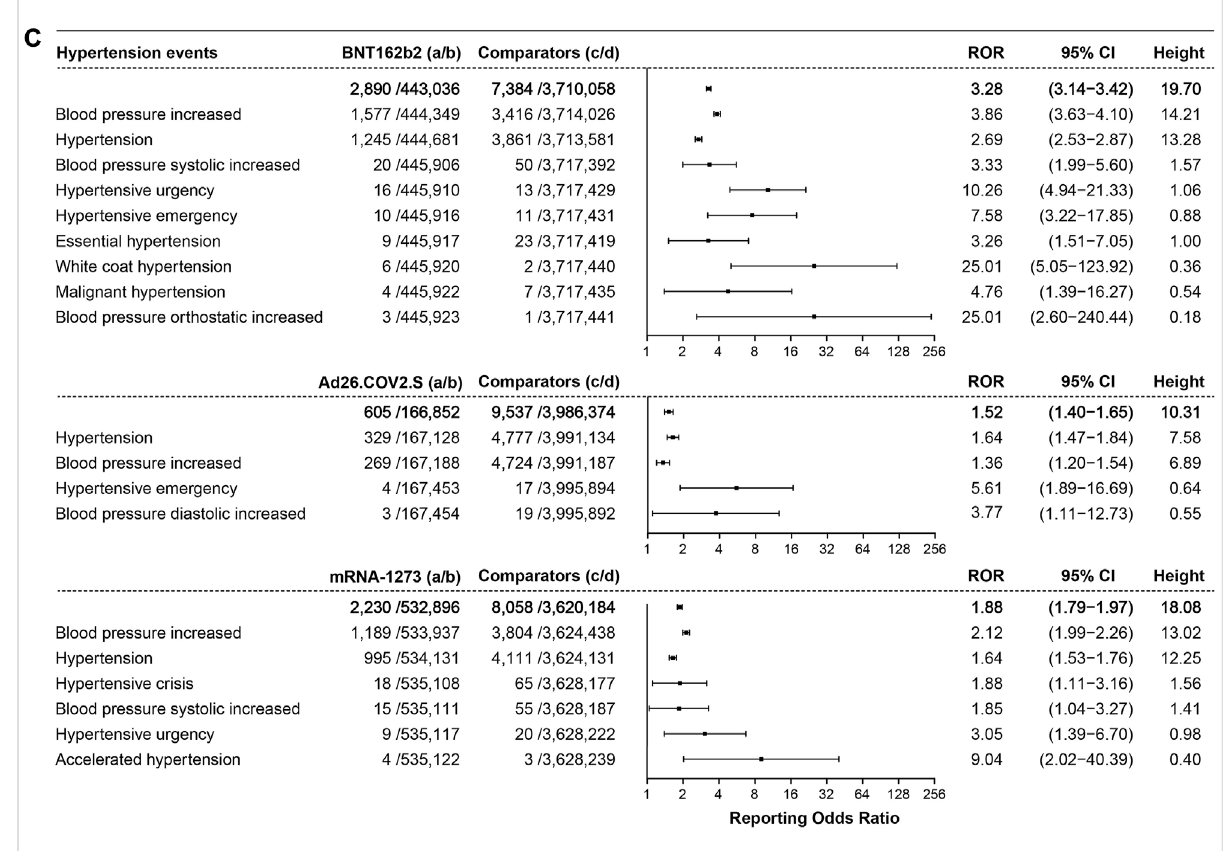
FIGURE 6 (C) ROR values and height of theCOVID-19 vaccinesof BNT162b2-, Ad26.COV2.S-,and mRNA-1273-associated hypertension events. a: cases of target hypertension events reported concerning the target COVID-19 vaccines; b: cases of other adverse events reported concerning the target COVID-19 vaccines; c: cases of target hypertension events reported concerning all the other vaccines; d: cases of other adverse events reported concerning all the other